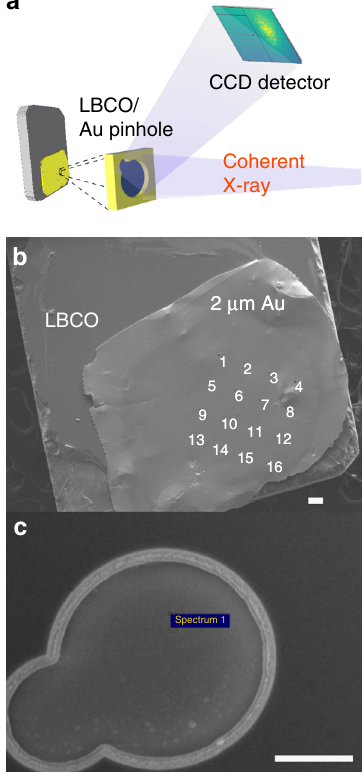
Fig. 1 Experimental setup. a The scattering geometry in which coherent X-rays illuminate the masked LBCO 1/8 sample and the CDW Bragg peak is measured on a CCD detector. b A SEM image of the LBCO 1/8 single crystal with a Au mask fi xed on top. Numbers 1 – 16 indicate the 16 pinholes drilled in the Au mask using a focused ion beam (FIB) prior to being fi xed on the crystal. The white scale bar represents 50 μ m. c A zoomed SEM image of pinhole #10, through which most of our data were taken. The white scale bar represents 5 μ